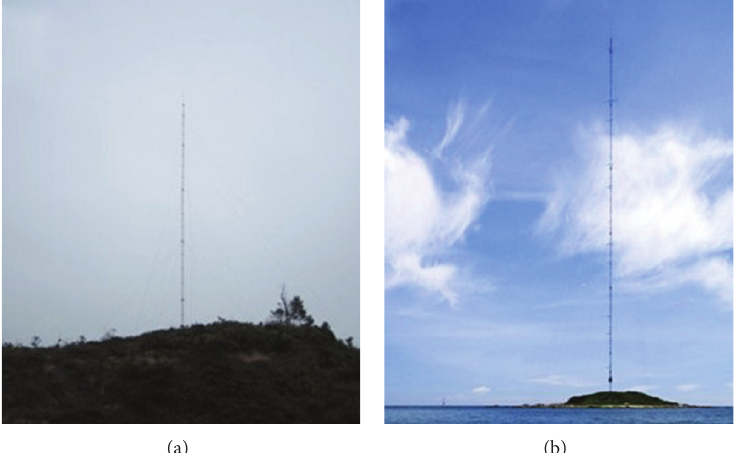
Figure 2: Sites of wind tower: (a) Sanjiao Island (where typhoon Nuri was observed) and (b) Zhizai Island (where typhoon Hagupit was